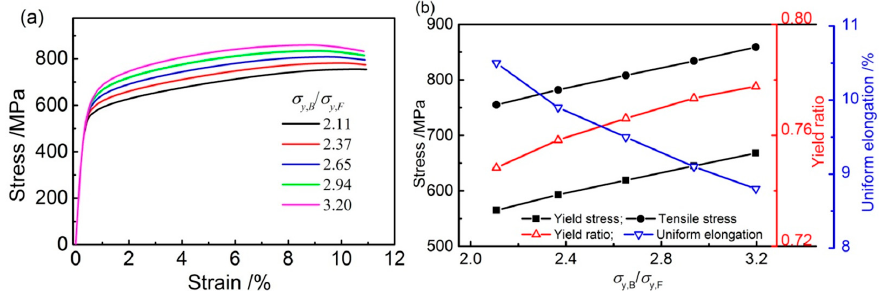
Figure 2. Simulated results of effect of σ y , B / σ y , F on ( a ) stress-strain curves, and ( b ) mechanical properties of mesostructure.